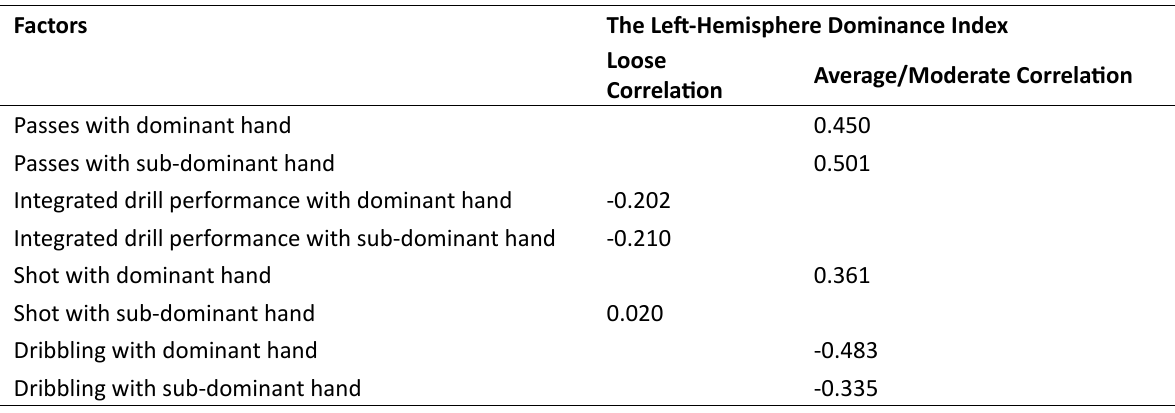
Table 3. Correlation of technical readiness and the left hemisphere dominance of basketball players aged 12-13